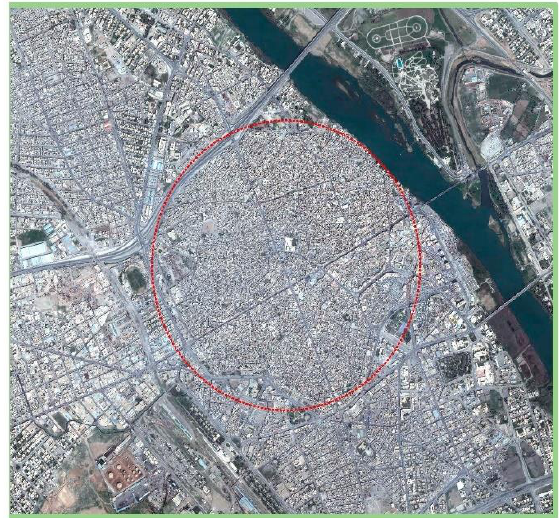
Figure 3. The study area: The old city of Mosul reproduced with permeation from [Google Earth] [23].